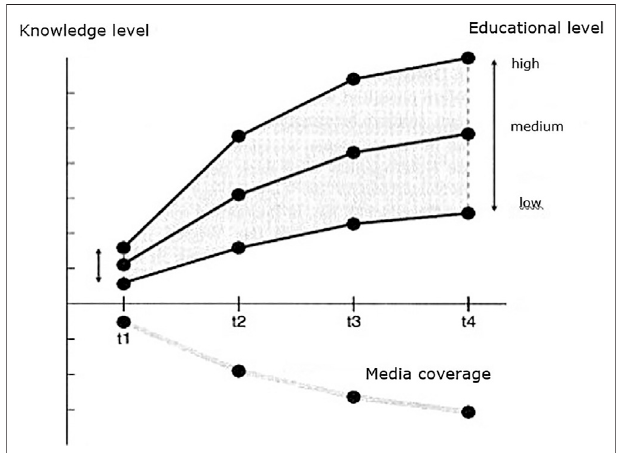
FIGURE 1 | Growth of knowledge gap (adapted from Bonfadelli and Friemel (2017), 242).